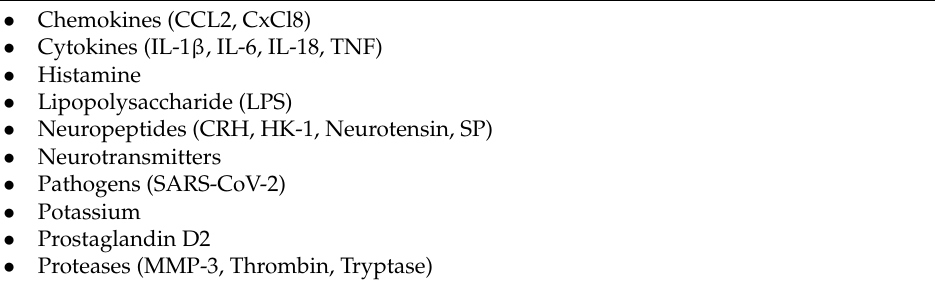
Table 2. Molecules Activating